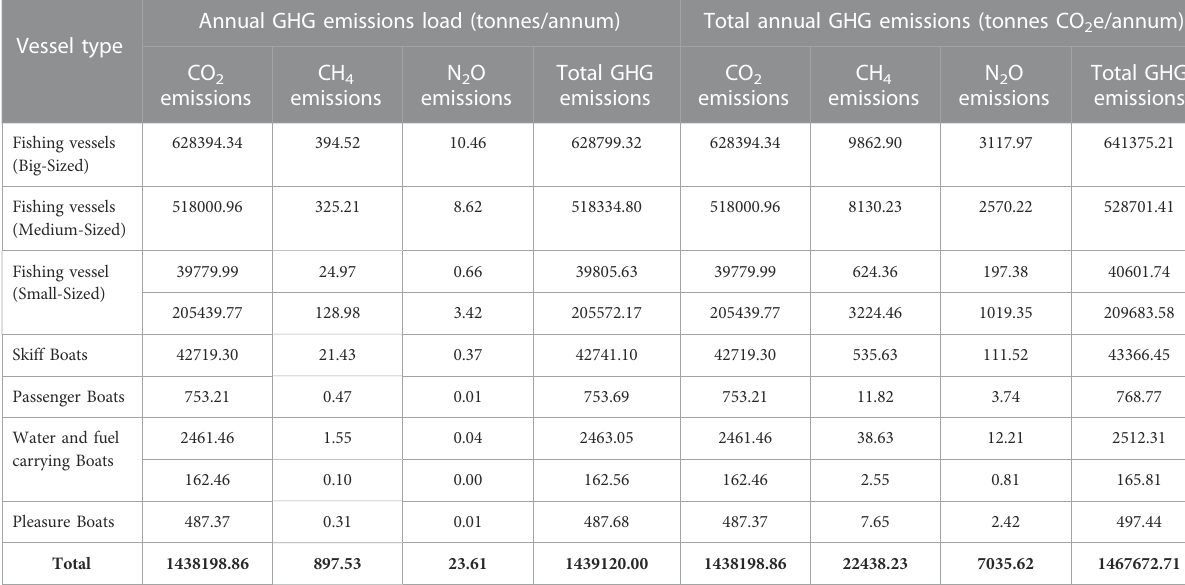
Bold are used for total values.